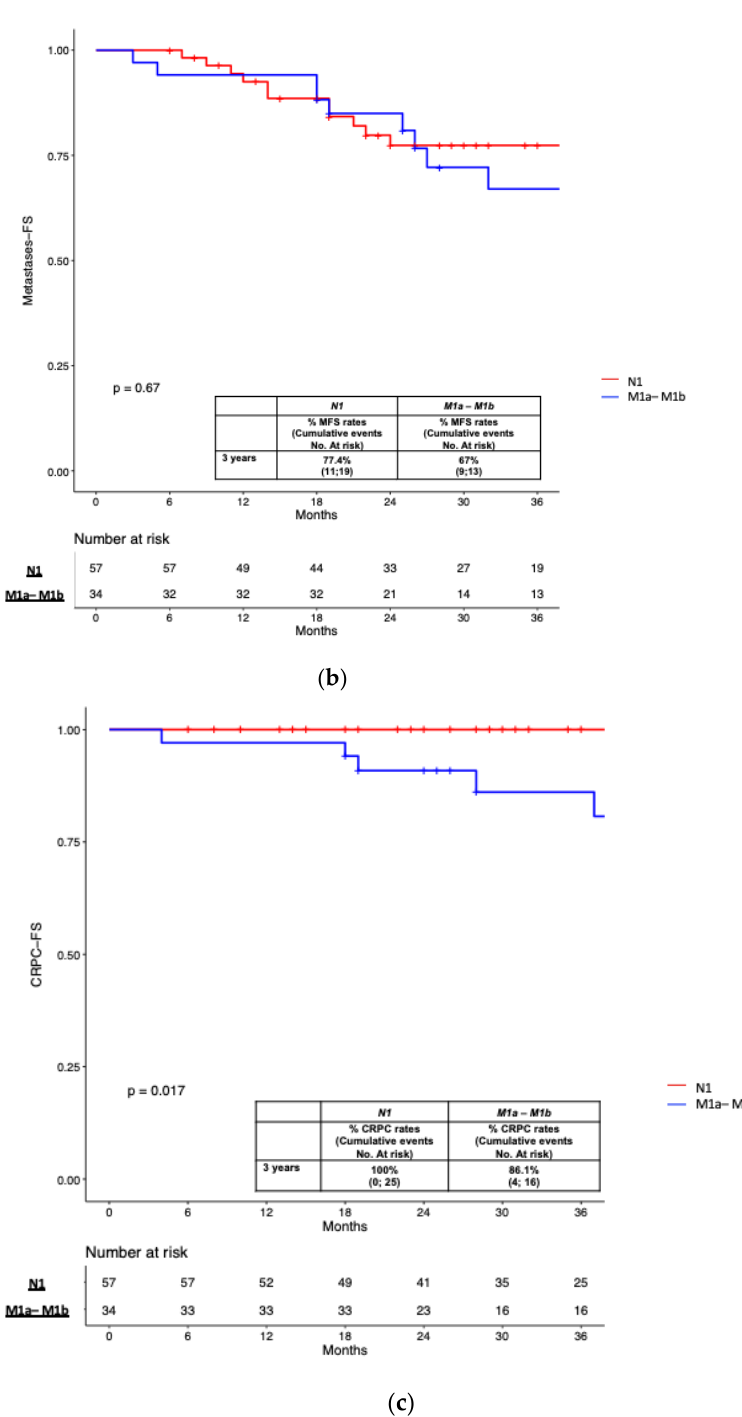
Figure 4. ( a ) Kaplan-Meier curve depicting Progression Free Survival (PFS) rates in patients treated with the MDT approach (n = 91) according to miTNM stage at PSMA-PET (miN1 vs. miM1a-M1b); ( b ) Kaplan-Meier curve depicting Metastases Free Survival (PFS) rates in patients treated with the MDT approach (n = 91) according to miTNM stage at PSMA-PET (miN1 vs. miM1a-M1b); ( c ) Kaplan-Meier curve depicting Castration Resistant Prostate Cancer Free Survival (CRPC-FS) rates in patients treated with the MDT approach (n = 91) according to miTNM stage at PSMA-PET (miN1 vs. miM1a-M1b).